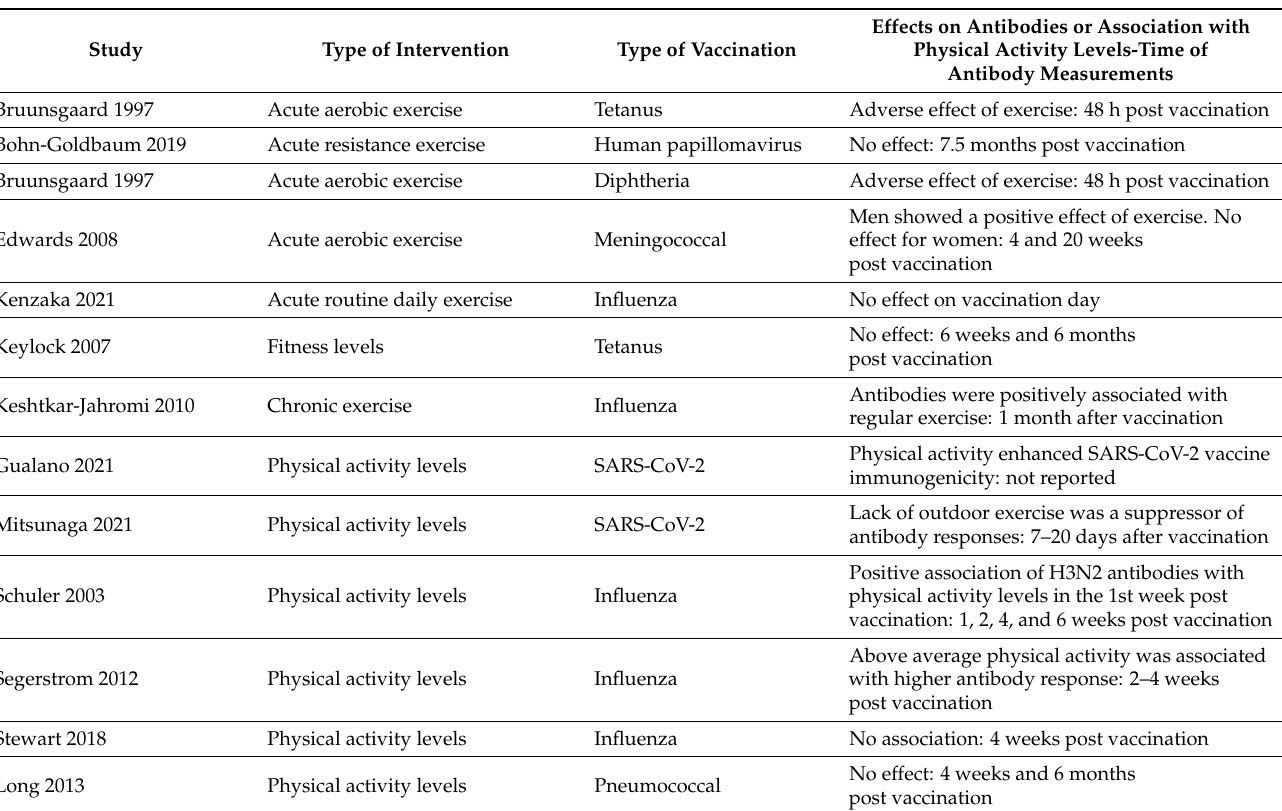
Table 1. Narrative data synthesis outcomes for the eligible studies that were not included in a